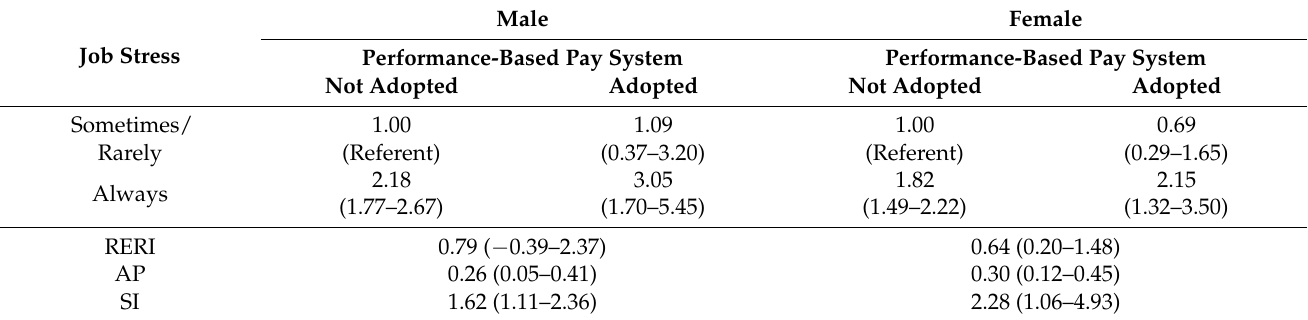
Table 4. The interaction effect of performance-based pay system and job stress on depressive/anxiety symptoms, stratified by